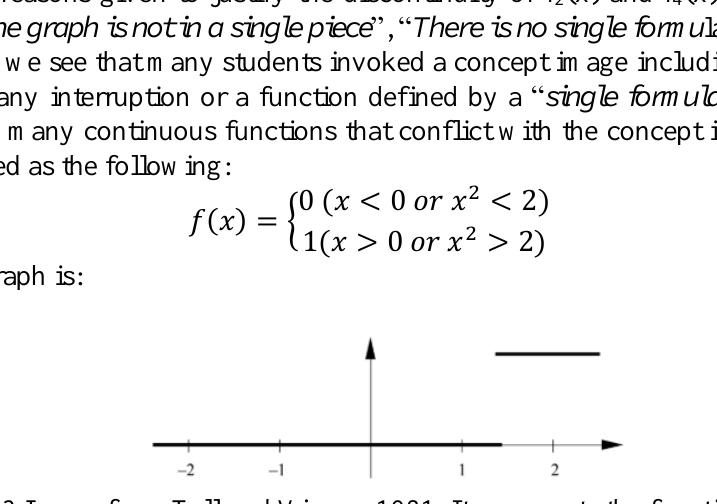
Figure 3.3 Image from Tall and Vinner, 1981. It represents the function defined